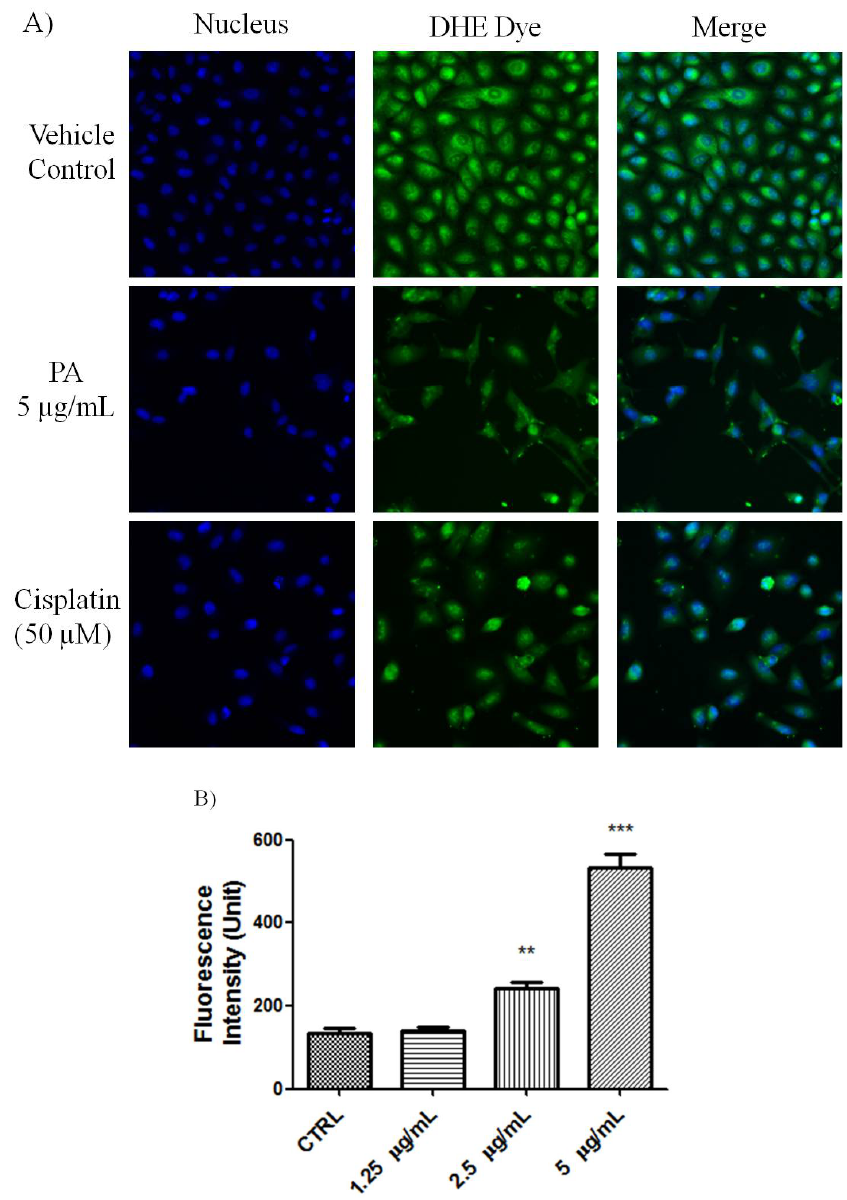
Figure 3. PA induced oxidative stress on A549 cells. ( A ) Fluorescent images of PA treated A549 cells stained with DHE dye. Cisplatin was included as positive control. PA induced oxidative stress was evidenced with increased ethidium dye, a product of DHE oxidation in the nuclues. Images were acquired using Cellomics ArrayScan reader; ( B ) The amount of ethidium, was quantified by compartmental analysis